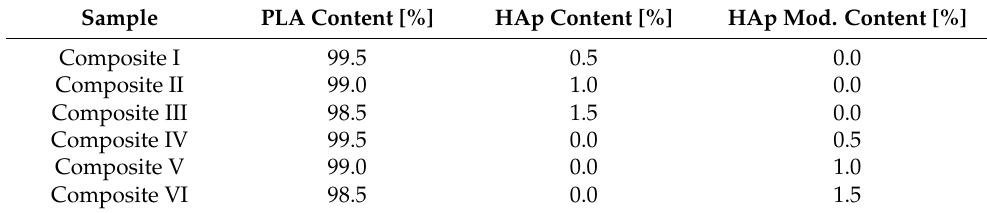
Table 1. Composition of the obtained composites.